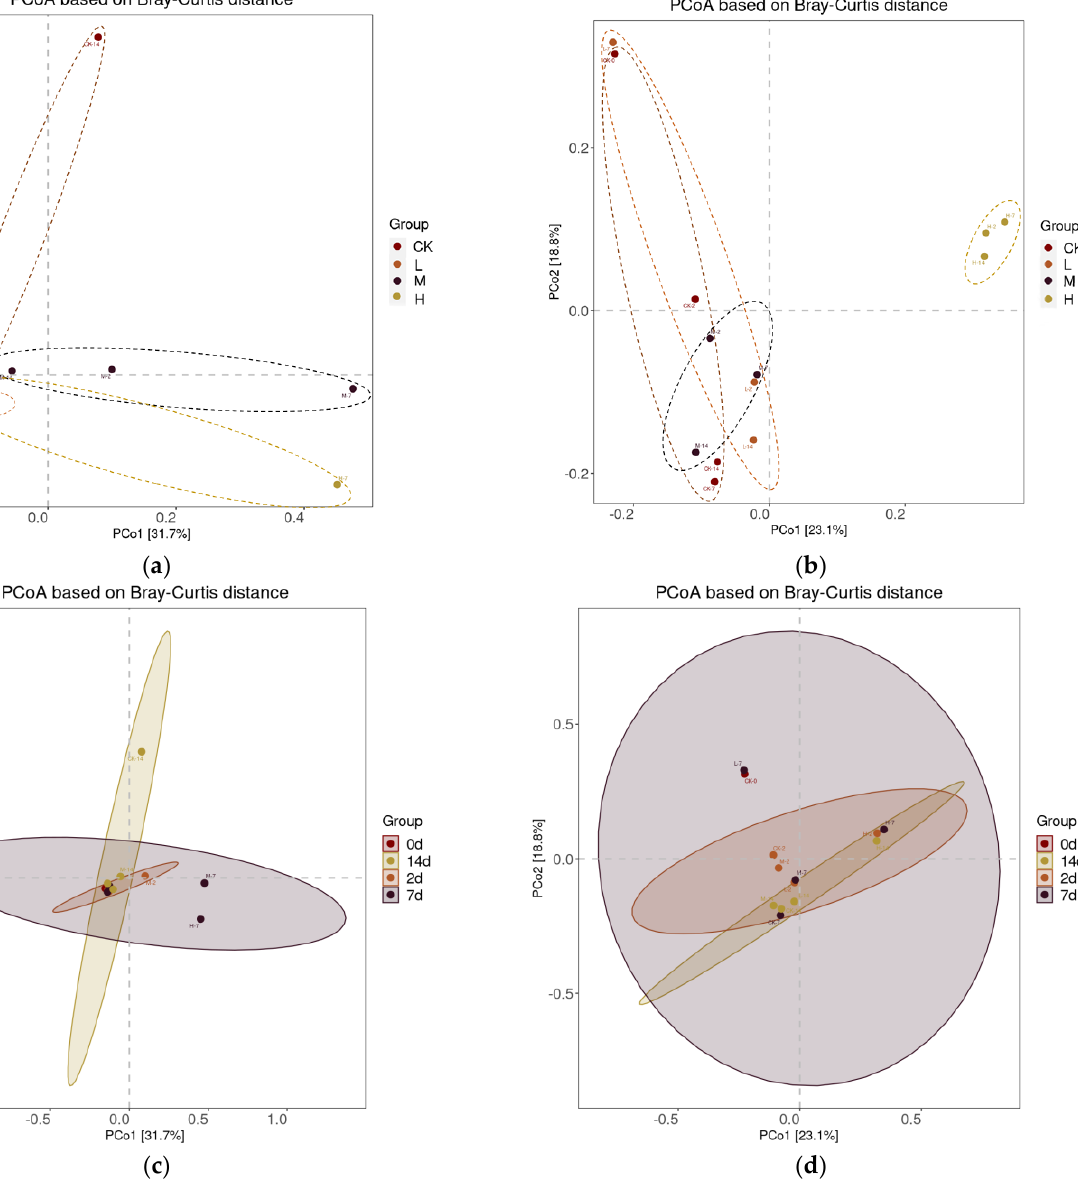
Figure 6. Principal Co − ordinates Analysis (PCoA) of bacteria ( a , c ) and fungi ( b , d ) based on Bray − Curtis distance. The picture ( a , b ) separately shows the difference of bacterial and fungal community composition of soil groups treated with different concentrations of volatile oil, while the picture ( c , d ) reveals the difference of bacterial and fungal community composition of soil groups at different treatment times, respectively. A point represents a sample, and points of the same color belong to a group. The solid circle represents the confidence ellipse with a 95% confidence interval, while the dotted circle is meaningless, just to better observe the same group of